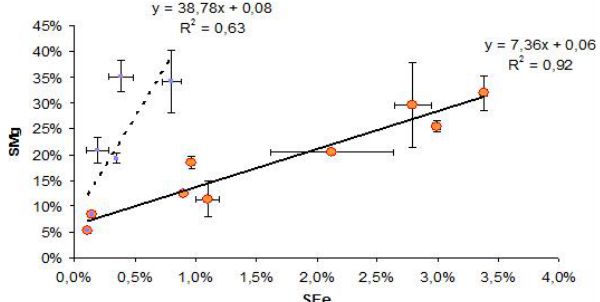
Fig. 3. Boxplot of Percentage solubility estimates of Fe for the 3 kinds of identified samples: DUST (13 Samples), BB1 (8 Samples) and BB2 (4 Samples). Whiskers are from minimum to maximum, box width represents the interquartile range and a stroke is plotted inside of the box to represent the median.